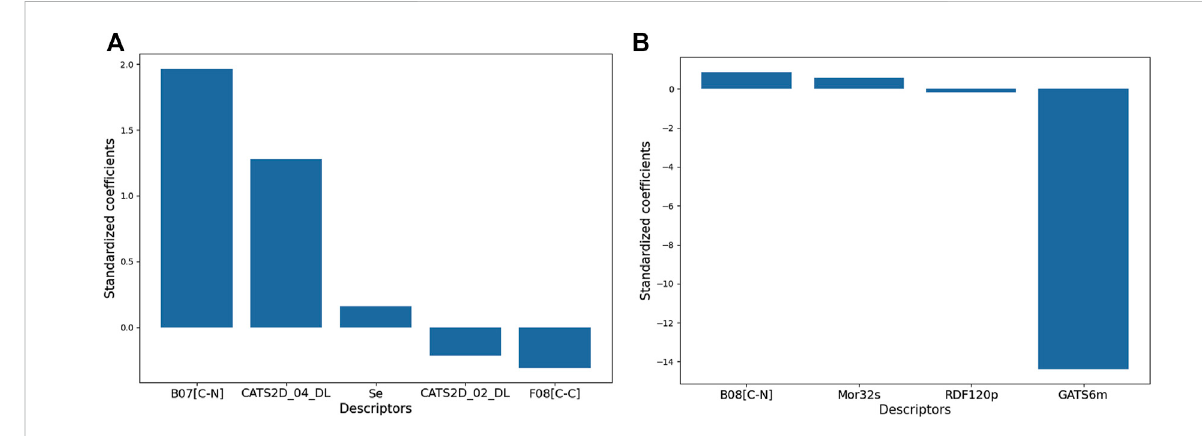
FIGURE 3 The relative signi fi cances of the molecular descriptors appearing in the 2D-QSAR models. The description of each descriptor can be found in the text.